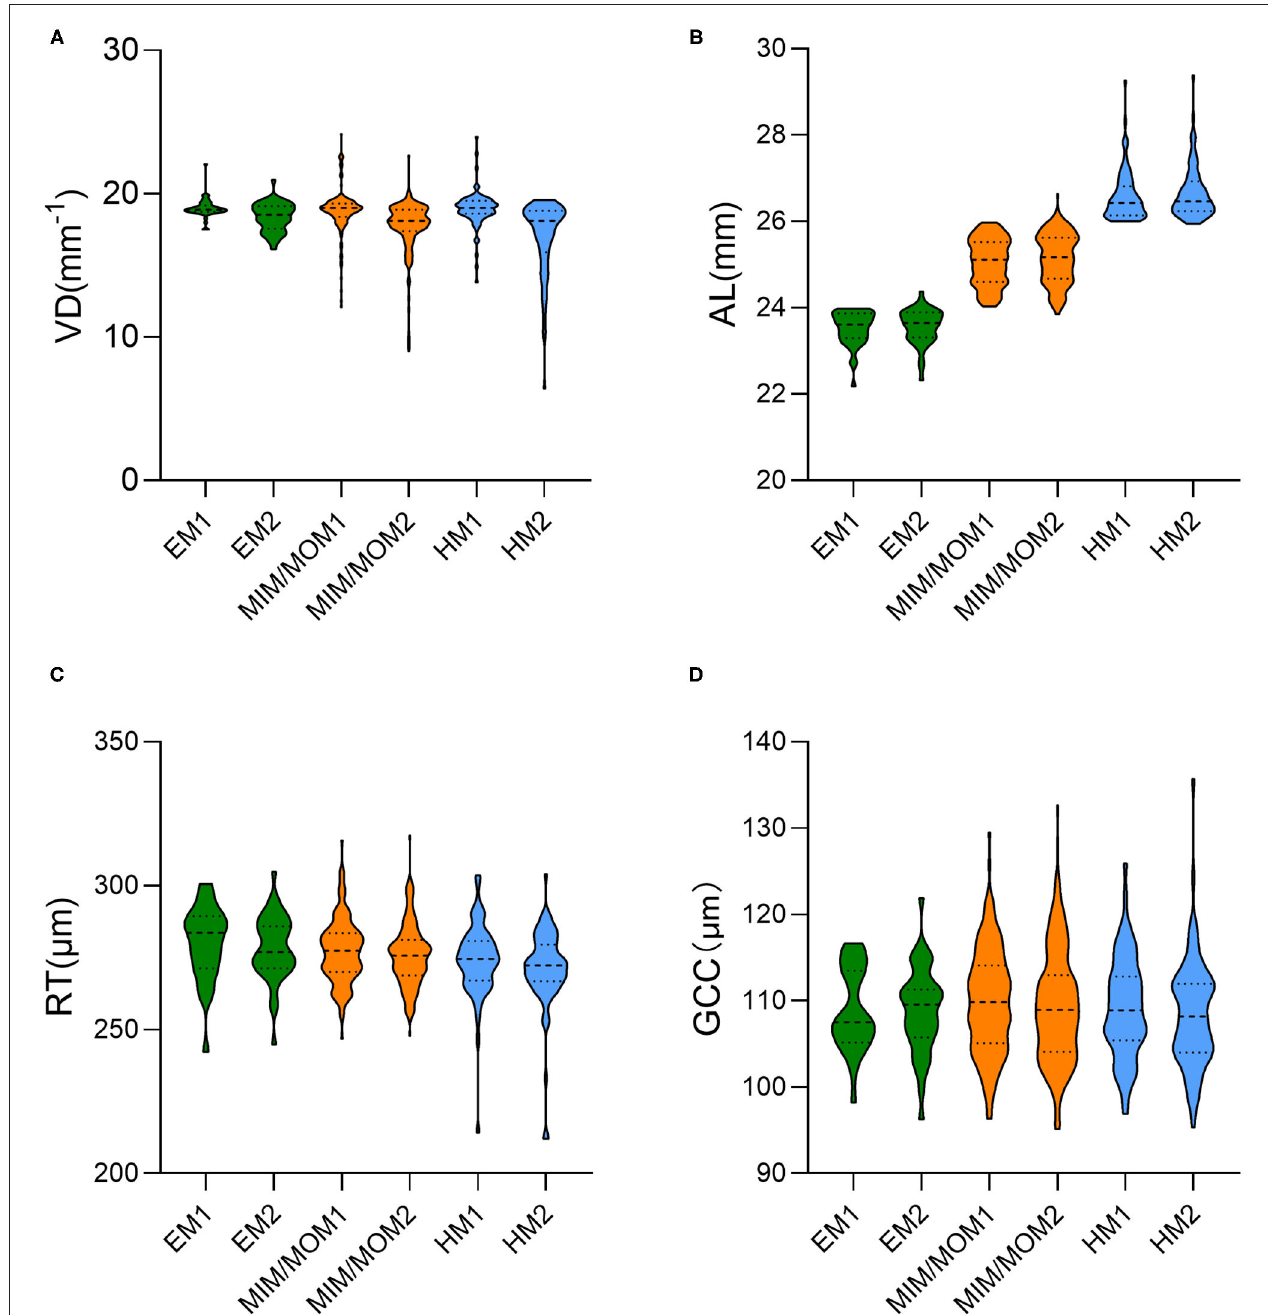
FIGURE 2 | The violin plot in distribution of (A) vessel density (VD), (B) axial length (AL), (C) retinal thickness (RT) and (D) ganglion cell complex (GCC) thickness in different groups at baseline and the end of follow-up. EM1, emmetropia at baseline; EM2, emmetropia at the end of follow-up; HM1, high myopia at baseline; HM2, high myopia at the end of follow-up; MIM/MOM1, mild-to-moderate myopia at baseline; MIM/MOM2, mild-to-moderate myopia at the end of follow-up.